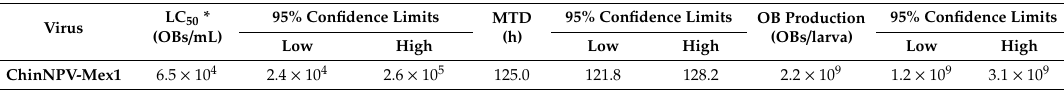
Table 2. Results of Probit analysis used to estimate median lethal concentration (LC 50 ) and median time to death (MTD) values for ChinNPV-Mex1 in C. includens second instars and OB production values for ChinNPV-Mex1 in C. includens fifth